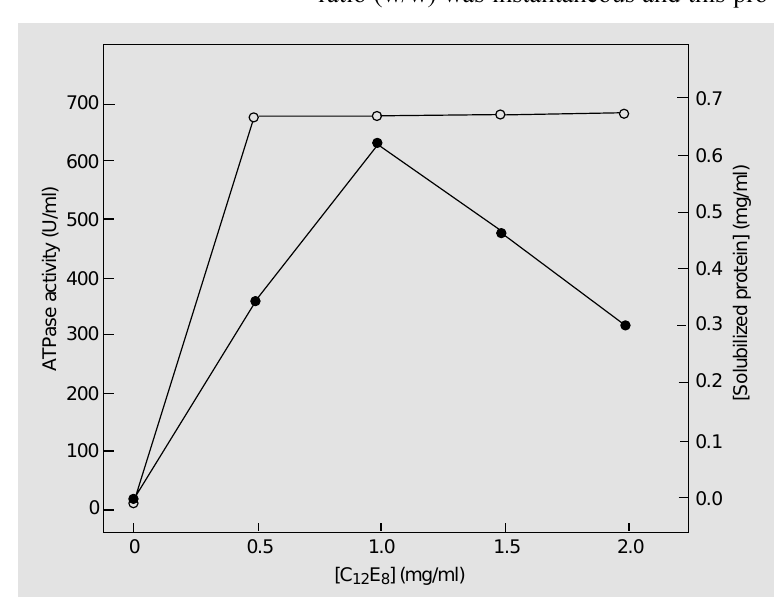
Figure 4. Chromatography of Na,K-ATPase solubilized with C 12 E 8 on a Sepharose 6B column. A sample of Na,K-ATPase solubilized with C 12 E 8 (1:1, w/w) contain- ing 154 U/mg was applied to a Sepharose 6B column (1.4 x 119 cm) equilibrated and eluted with 5 mM Tris- HCl buffer, pH 7.0, containing 1.0 mM EDTA, 150 mM KCl and 0.005 mg/ml C 12 E 8 , at a flow rate of 21 ml/h. Fractions of 3.5 ml were collected and aliquots were assayed for protein concentration (dotted line) (A 280 nm ); PNPPase activity (broken line) and ATPase activity (solid line). The fractions indicated (peak II) were pooled and correspond to solubilized and purified Na,K- ATPase. Inset : Non-denaturing polyacrylamide gel elec- trophoresis of Na,K-ATPase in different purification steps: gel 1 - C 12 E 8 -solubilized extract stained with silver nitrate; gel 2 - purified enzyme (peak II) stained with silver nitrate, and gel 3 - phosphohydrolytic activity of purified enzyme developed with 0.12% (w/v) 1-naphthyl phosphate and 0.12% (w/v) fast blue RR, in the normal kinetic assay medium.